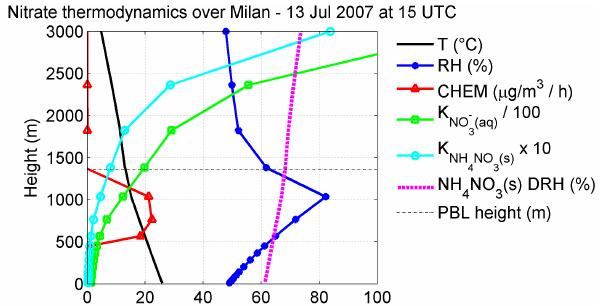
Figure 12. Simulated vertical profile of relative humidity (blue) and particulate-nitrate net chemical production term (red) at 16:00LST on 13 July 2007 over Milan. Also shown are the vertical profiles of equilibrium constants of aqueous-phase nitrate (green) and solid ammonium nitrate (cyan), and ammonium nitrate deliquescence rel- ative humidity (magenta). The height of PBL is denoted by the hor- izontal black dashed line. Please note that equilibrium constants are scaled by the constant factors shown in the inset legend to fit on the same abscissa range.